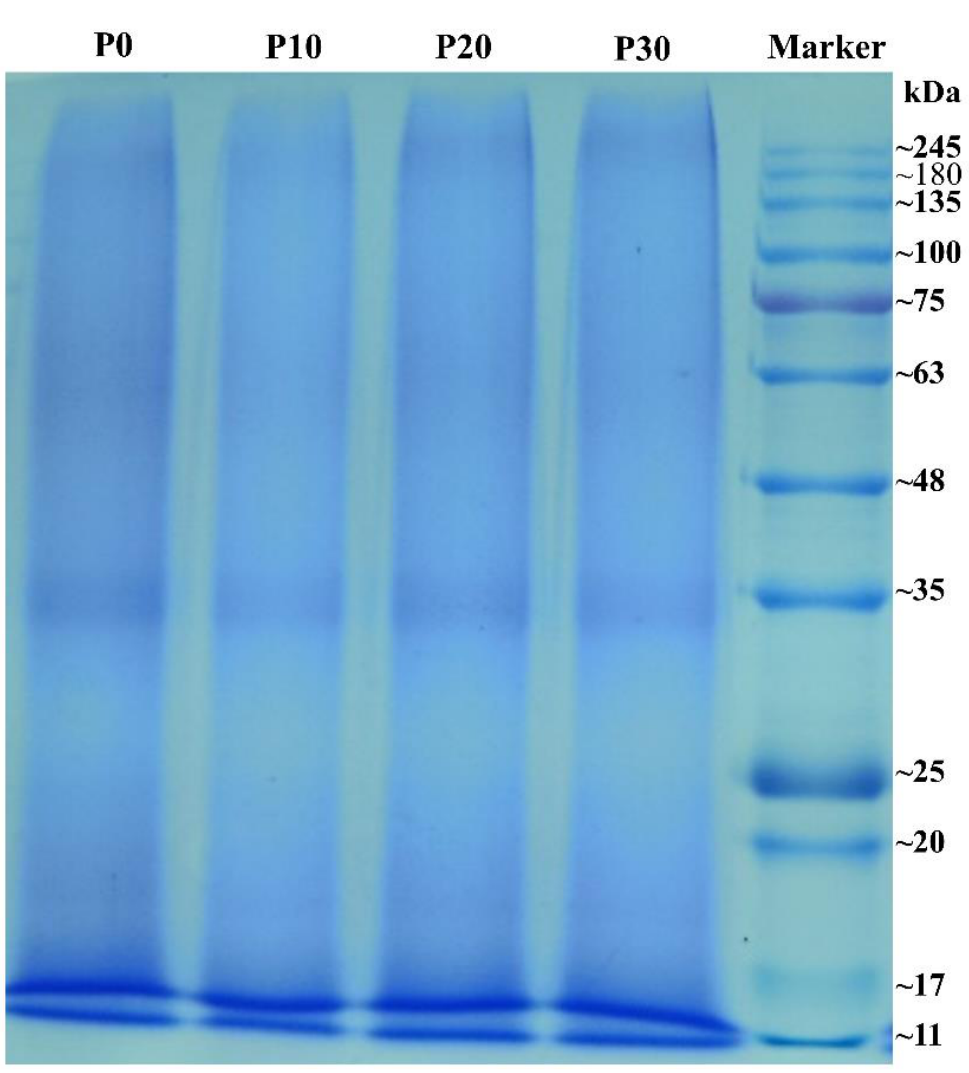
Figure 1. SDS-PAGE analysis of rice protein or homogenized proteins. P0, rice protein; P10, P20 and P30 represented the rice protein blend with homogenization for 0, 10, 20 and 30 min, respectively.